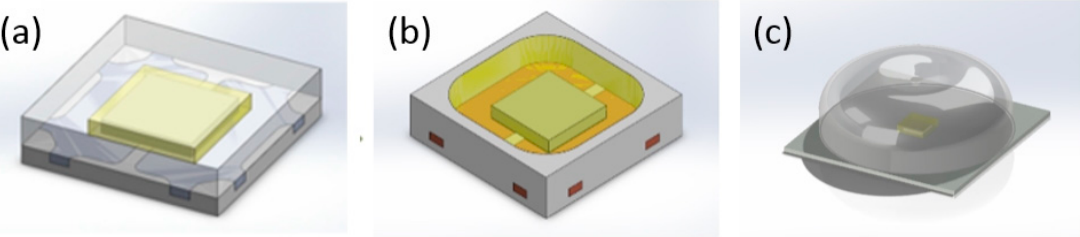
Figure 1. Schematic diagram ( a ) CSP, ( b ) SMD, and ( c ) FDCSP.